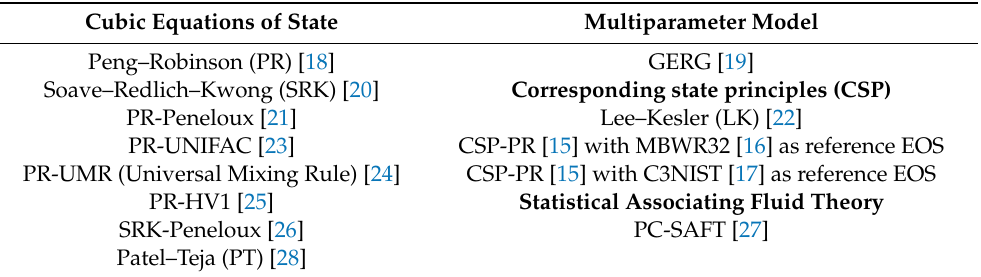
Table 3. Equations of state investigated in this